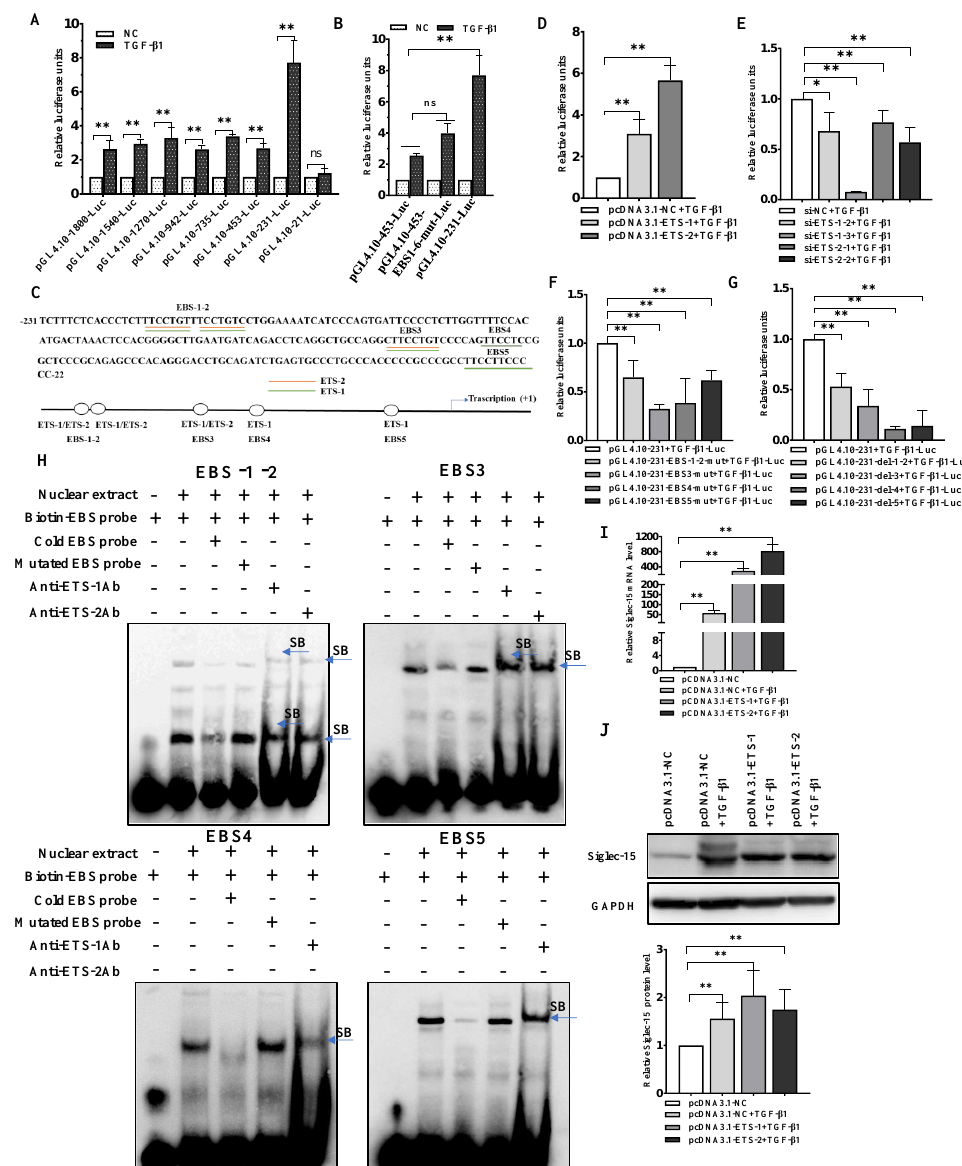
Figure 5. TGF- β 1 upregulated the expression of Siglec-15 in HepG2 cells by facilitating the binding of ETS-1 and ETS-2 to EBSs in the Siglec-15 promoter. ( A ) Activity analysis of the Siglec-15 promoter in HepG2 cells treated with TGF- β 1 (50 ng/mL) for 24 h and then transfected with each of the Siglec-15 promoter constructs and pRL-TK. ( B ) Luciferase activity in HepG2 cells treated with TGF- β 1 (50 ng/mL) for 24 h and then transfected with pGL4.10-231-Luc, pGL4.10-453-Luc or the mutant plasmid with all the six EBSs mutated. ( C ) Nucleotide sequence of the − 231 to − 22 nt region of the Siglec-15 promoter. The five putative transcription factor binding sites are underlined in the sequence and schematically depicted below. ( D , E ) Effect of TGF- β 1 on Siglec-15 promoter activity in HepG2 cells with ETS-1 or ETS-2 overexpression or knockdown. pcDNA3.1-ETS-1, pcDNA3.1-ETS-2, si-ETS-1, or si-ETS-2 was co-transfected with pGL4.10-231-Luc into HepG2 cells treated with TGF- β 1 (50 ng/mL) for 24 h, then luciferase activities were measured 48 h after transfection. The RLU were obtained by comparison with empty vector pcDNA3.1/Hygro (+) or siRNA negative control (NC), respectively. ( F , G ) Effect of EBS mutation or deletion on TGF- β 1-induced Siglec-15 promoter activity. The variants of EBS mutations or deletions (0.25 µ g) were co-transfected with 10 ng of pRL-TK